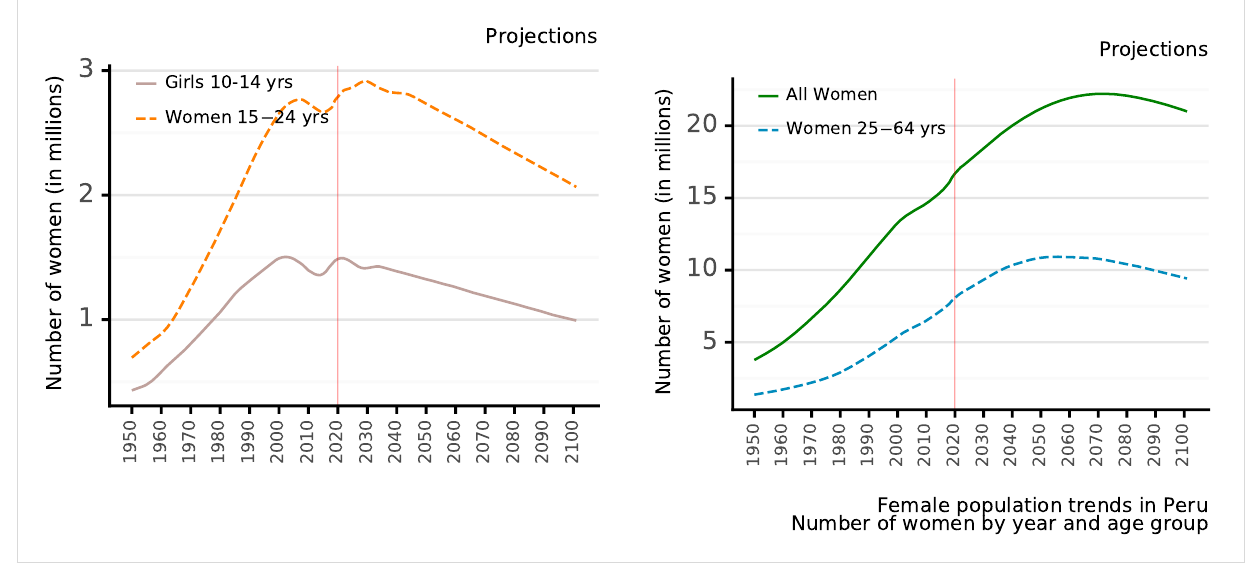
Figure 3: Population trends in four selected age groups in